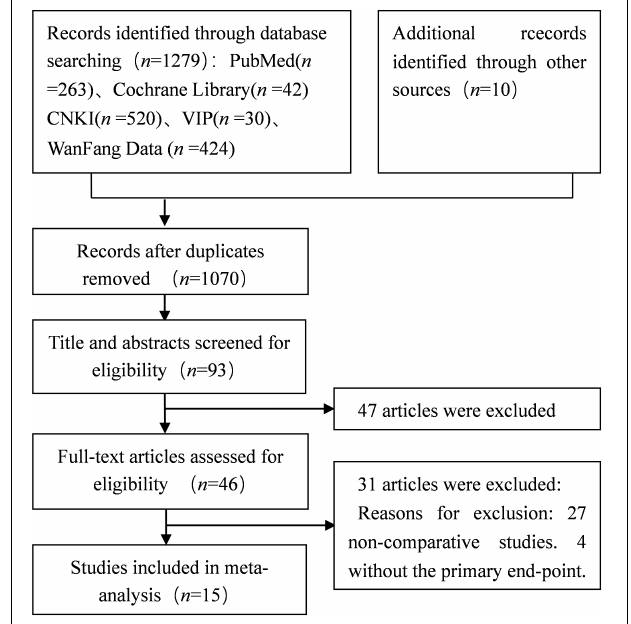
FIGURE 1 | Flow diagram of study